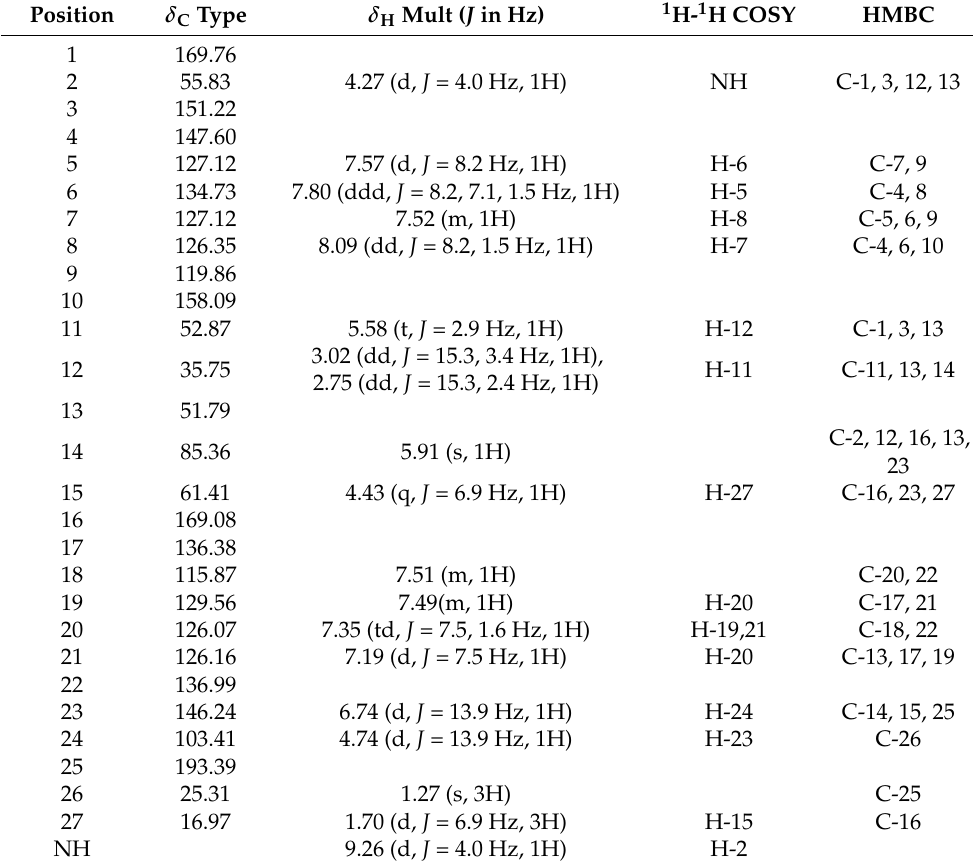
Table 1. 1 H (400 MHz), 13 C (100 MHz) NMR Data for Compound 1